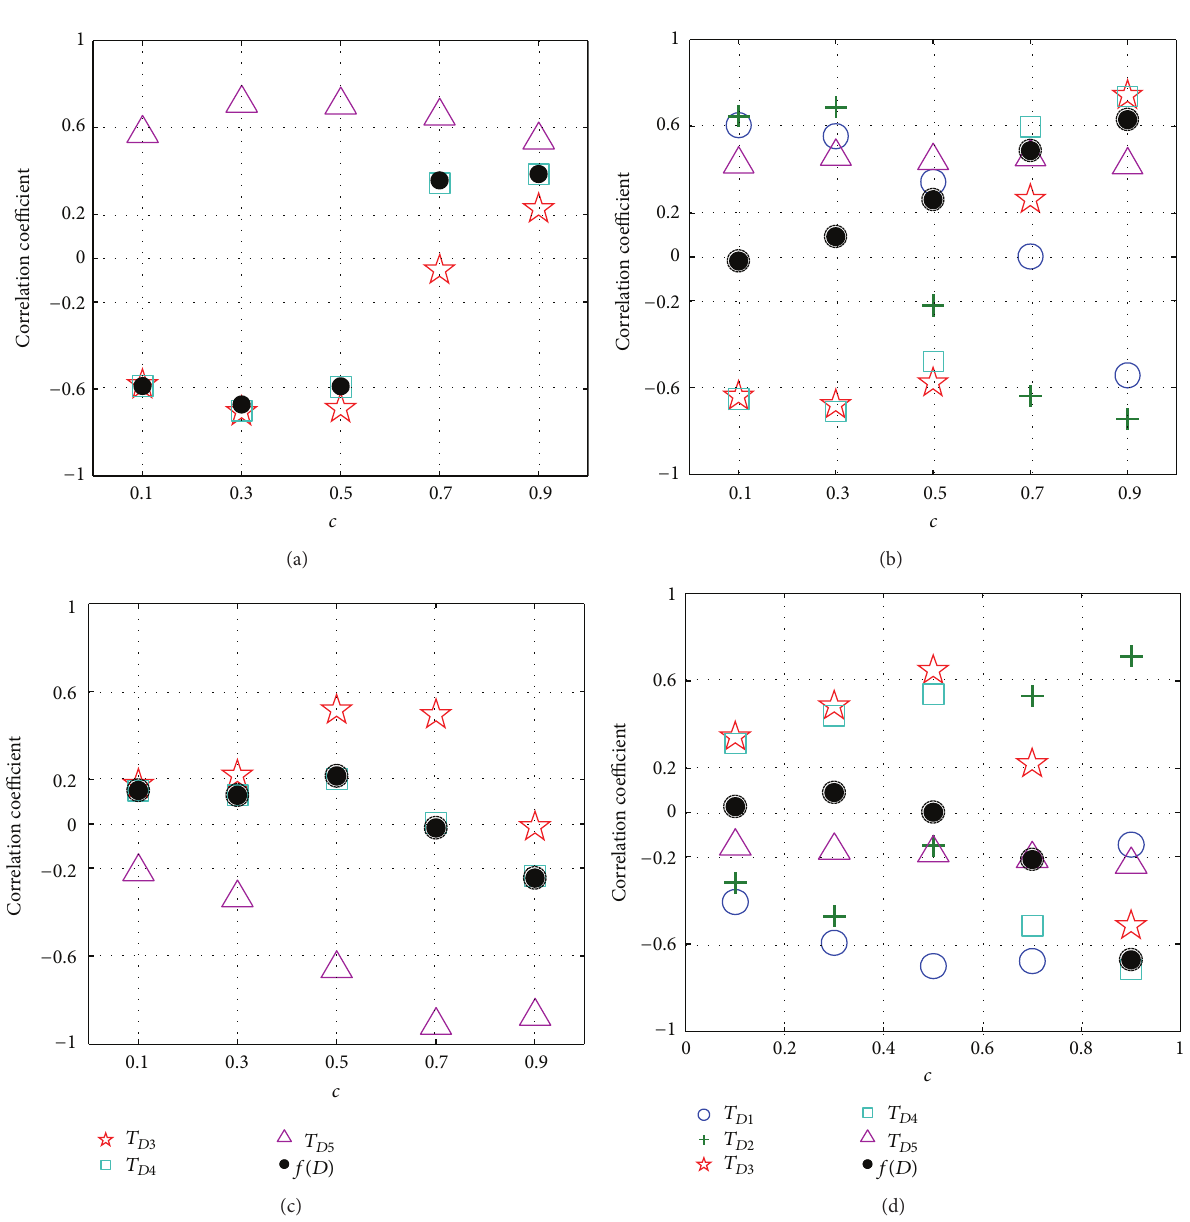
Figure 16: (a) Correlation coefficients for the 𝑇 𝐷3 −𝑎 𝑇 , 𝑇 𝐷4 −𝑎 𝑇 , 𝑇 𝐷5 −𝑎 𝑇 , and 𝑓(𝐷)−𝑎 𝑇 correlations on 𝑐 = 0.1 , 0.3, 0.5, 0.7, and 0.9 isosurfaces for case P3. (b) Correlation coefficients for the 𝑇 𝐷1 − 𝑎 𝑇 , 𝑇 𝐷2 − 𝑎 𝑇 , 𝑇 𝐷3 − 𝑎 𝑇 , 𝑇 𝐷4 − 𝑎 𝑇 , 𝑇 𝐷5 − 𝑎 𝑇 , and 𝑓(𝐷) − 𝑎 𝑇 correlations on 𝑐 = 0.1 , 0.3, 0.5, 0.7, and 0.9 isosurfaces for case V2. (c) Correlation coefficients for the 𝑇 𝐷3 − 𝜅 𝑚 , 𝑇 𝐷4 − 𝜅 𝑚 , 𝑇 𝐷5 − 𝜅 𝑚 , and 𝑓(𝐷) − 𝜅 𝑚 correlations on 𝑐 = 0.1 , 0.3, 0.5, 0.7, and 0.9 isosurfaces for case P3. (d) Correlation coefficients for the 𝑇 𝐷1 −𝜅 𝑚 , 𝑇 𝐷2 −𝜅 𝑚 , 𝑇 𝐷3 −𝜅 𝑚 , 𝑇 𝐷4 −𝜅 𝑚 , 𝑇 𝐷5 −𝜅 𝑚 , and 𝑓(𝐷)−𝜅